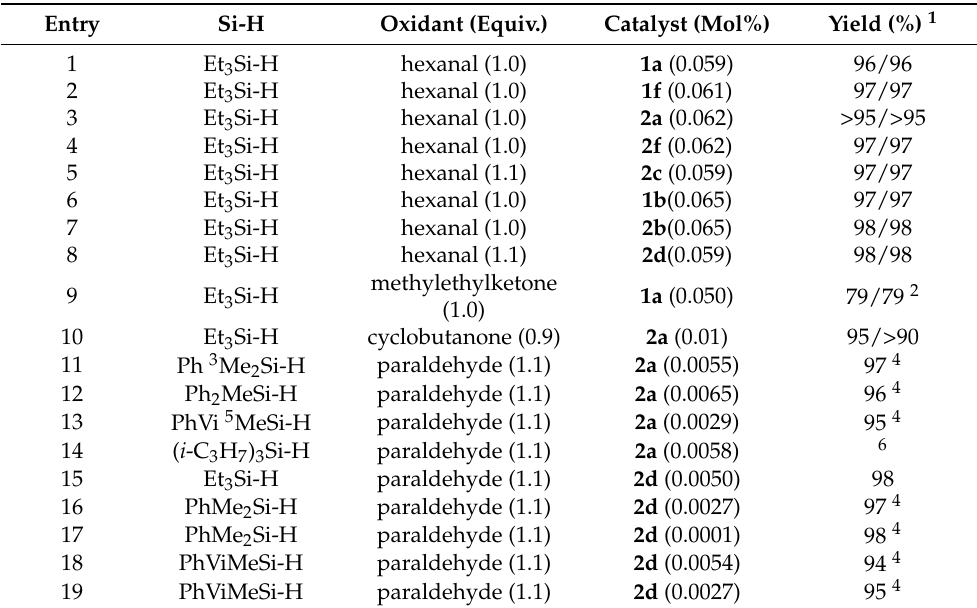
paraldehyde (1.1)